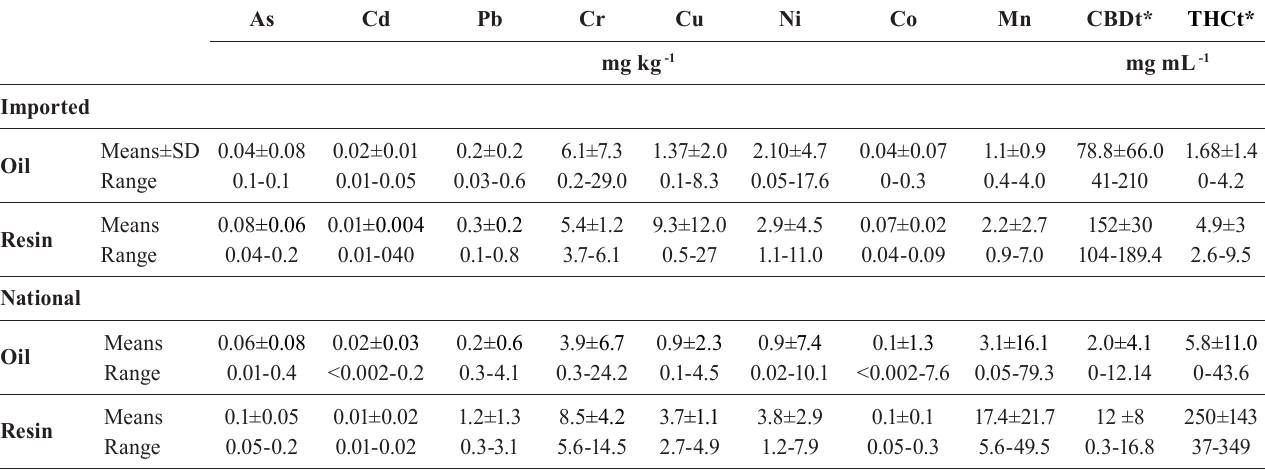
TABLE IV - Concentration of inorganic elements ± standard deviation (SD) and cannabinoids in medicinal Cannabis resins consumed by pediatric patients in Brazil As Cd Pb Cr